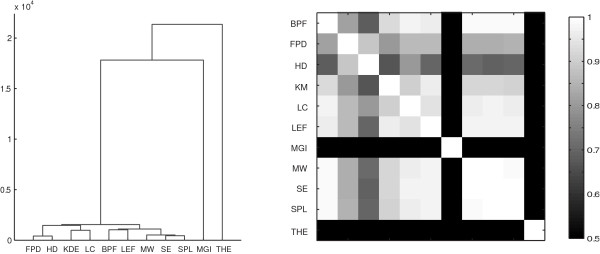
Dendrogram and pairwise correlation coefficients calculated based on object counts for all three image sets show similarities between algorithms. Correlation values lower than 0.5 are shown as black in the figure.